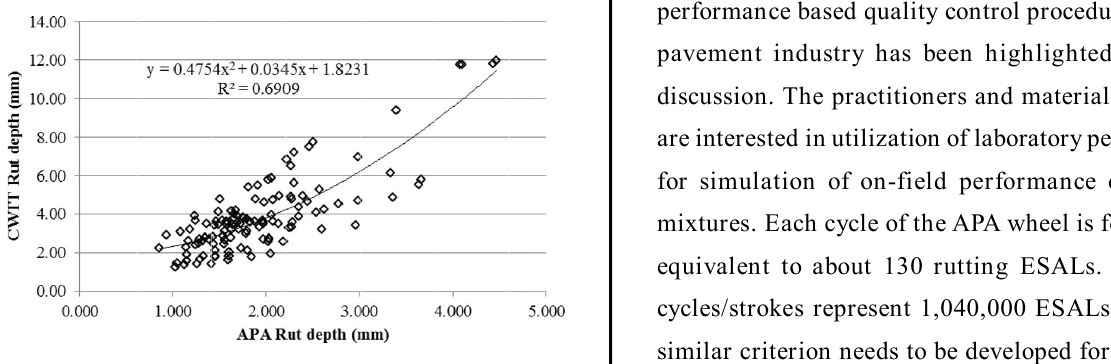
FIG. 13. CORRELATION PLOT BETWEEN CWTT RUT DEPTH AND APA RUT